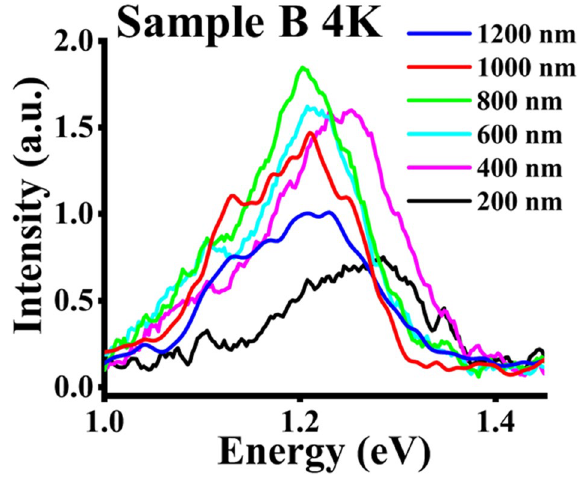
Figure 7. 4 K PL measurements for sample B for different pitch lengths.